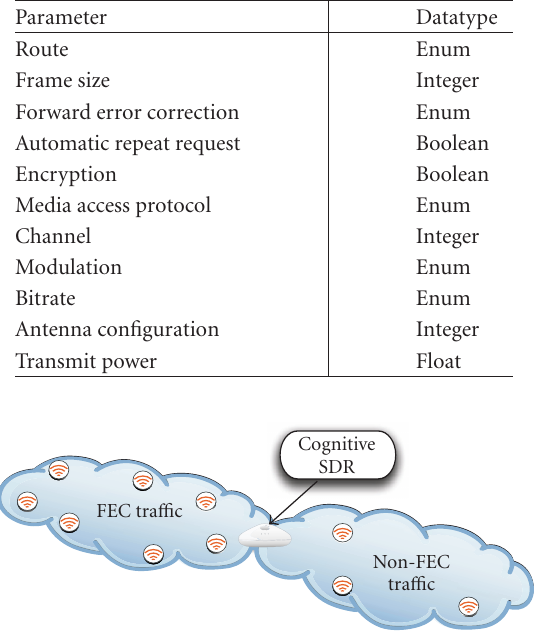
Figure 1: Dynamic MAC layer bridging using C/SDR.